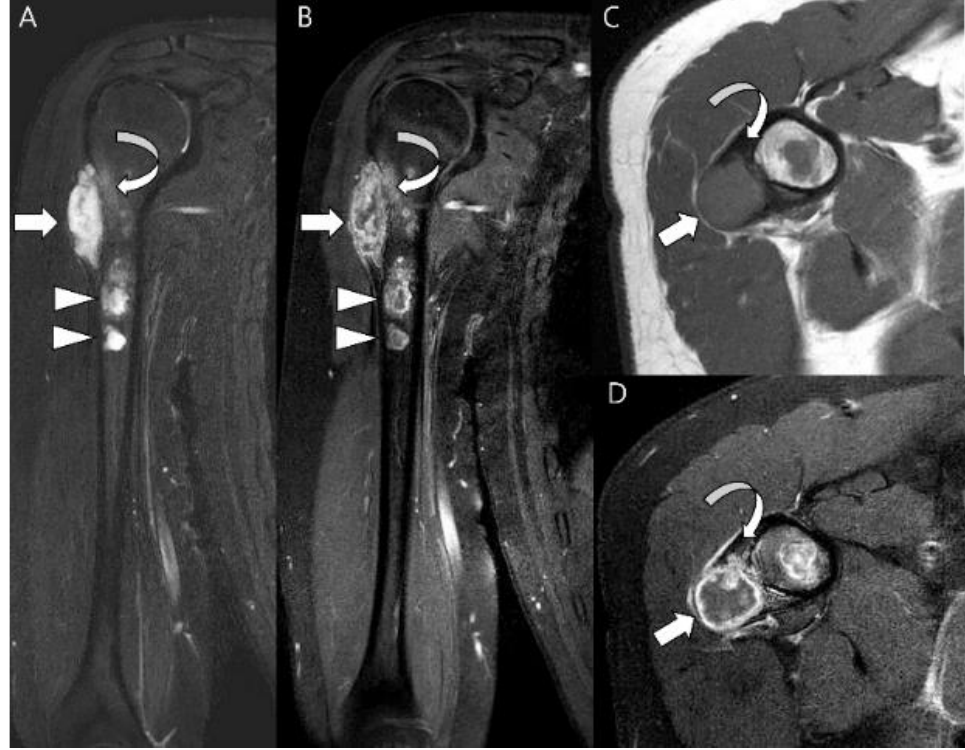
Figure 9. Secondary central chondrosarcoma of the humerus in a 19-year-old man. ( A ) Coronal T2-weighted image and ( B ) coronal T1-weighted enhanced images with fat suppression show multiple intramedullary chondroid tumors (arrowheads) with peripheral and septal enhancement in the humerus, suggesting enchondromatosis. The major lesion shows bone expansion at the metaphysis (arrow) with peritumoral edema and enhancement (curved arrow). ( C ) Axial T1-weighted and ( D ) enhanced images show a peripherally enhancing major lesion (arrow) with cortical remodeling (curved arrow).